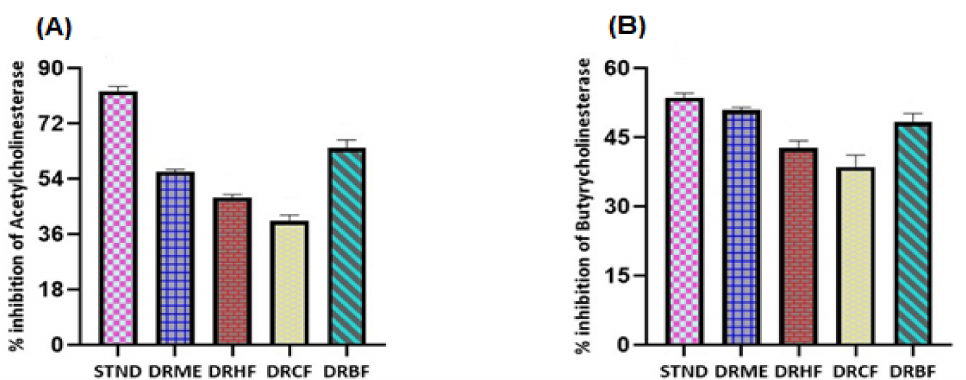
Figure 5. ( A ) Acetylcholinesterase inhibition of galantamine (standard) and extract/fractions and ( B ) butyrylcholinesterase inhibition of galantamine (standard) and extract/fractions of Dracaena reflexa. STND: galantamine (Standard); DRME: methanolic extract; DRHF: n -hexane fraction; DRCF: chloroform fraction; and DRBF: n -butanol fraction.